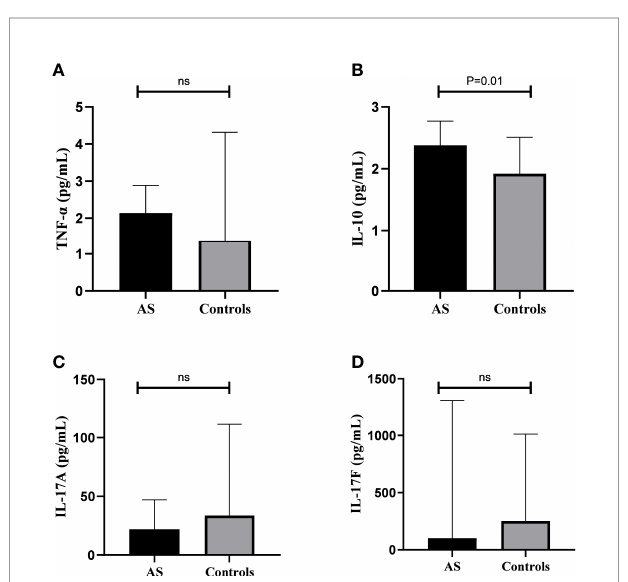
FIGURE 2 | Comparison between patients and controls for cytokine levels. (A) Comparison of TNF- a levels between patients and controls; (B) Comparison of IL-10 levels between patients and controls; (C) Comparison of IL-17A levels between patients and controls; (D) Comparison of IL-17F levels between patients and controls. AS, ankylosing spondylitis; ns, not signi fi cant.